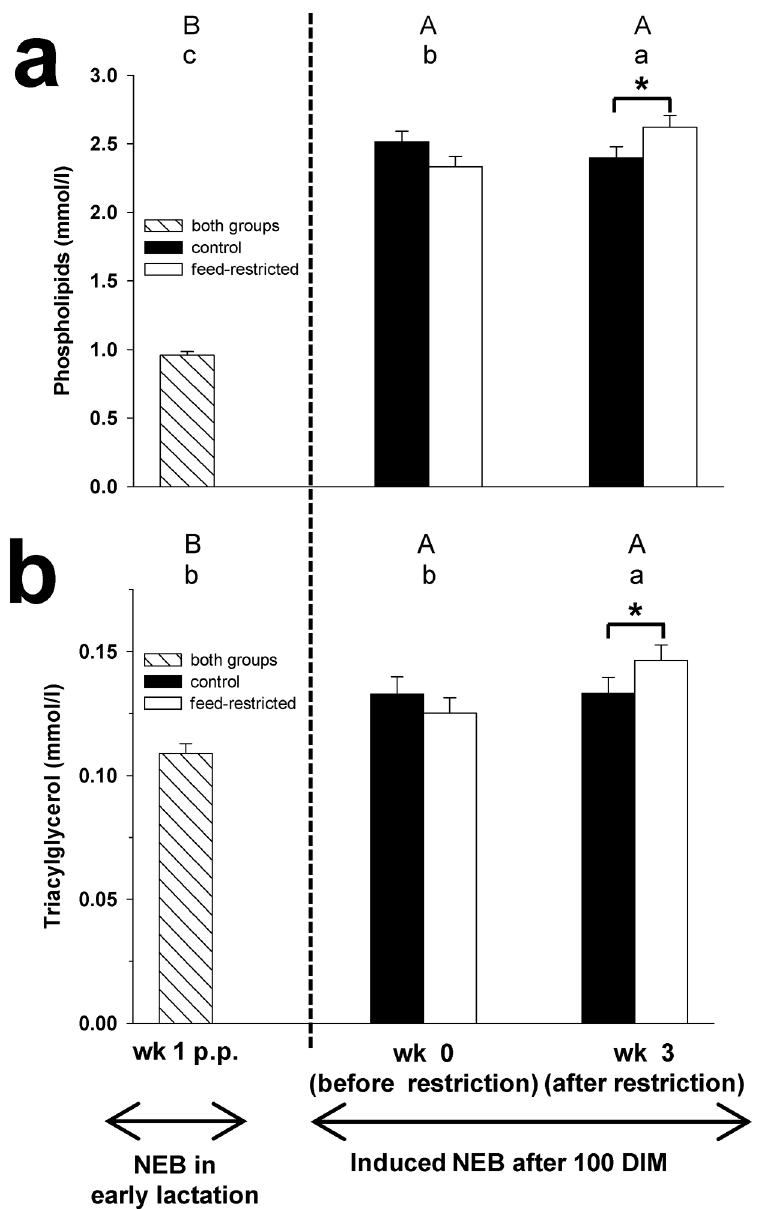
Fig 3. Phospholipids and TAG. Plasma concentration of phospholipids (Fig 3a) and triacylgycerol (Fig 3b) in week 1 p.p., and before (week 0) and after (week 3) feed restriction in mid-lactation. Changes over time within the groups are marked with superscripts (A to C for the control group (CON); a to c for the feed- restricted group (RES); P < 0.05). Differences between control (CON) and feed-restricted (RES) group in week 3 are indicated by * ( P < 0.05). Data are presented as means ± standard error of the mean.